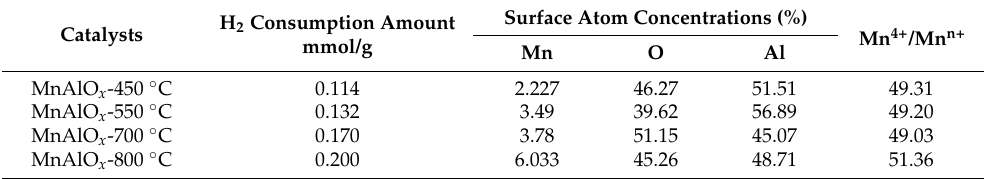
Table 3. H 2 consumption amount, surface atomic concentrations of Mn, O, Al, and the relative concentration